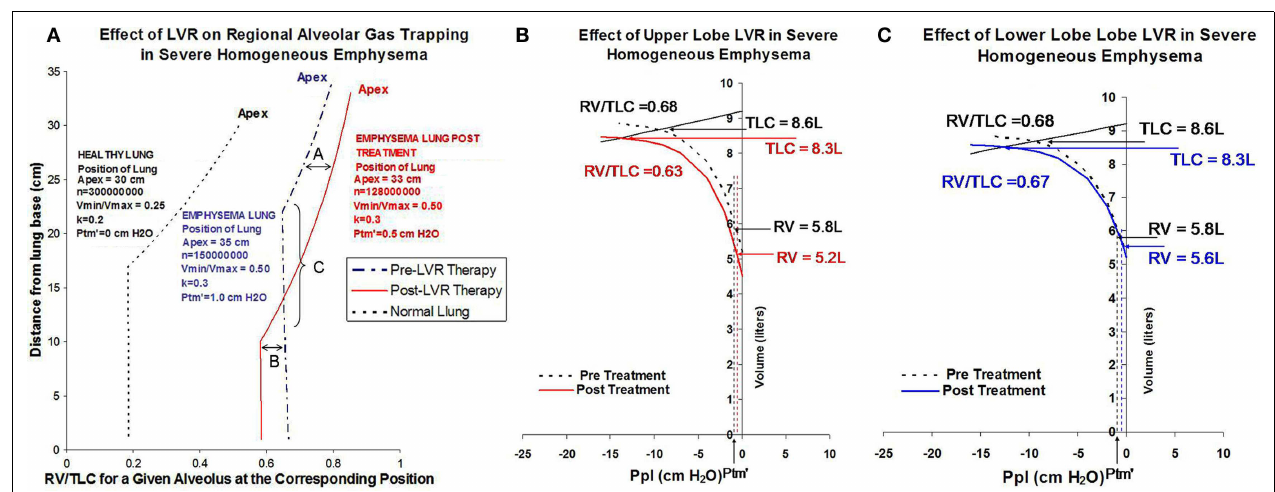
therapy causes a caudal shift in the position of at which airway closure occurs, labeled in this figure as effect as “C.” Because lower lobe airways remain opened to a greater extent following lung volume reduction, they are able to deflate to a greater extent.This is labeled in this figure as effect “B.” (B) Simulates the effects of a 25% decrease in the number of alveoli in the upper lobes on overall gas trapping (RV/TLC) and recoil pressure. (C) Shows a corresponding simulation for the equivalent lower lobe volume reduction (elimination of the same number of alveoli). In this example, upper lobe volume reduction is associated with a 6% decrease in overall gas trapping, while lower lobe volume reduction is associated with a 1% decrease in overall gas